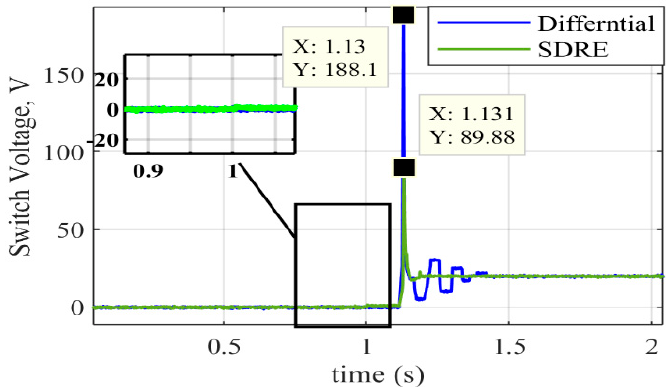
Figure 22. Voltage of IGBT breakers with snubber attendance in differential, and SDRE observer modes.